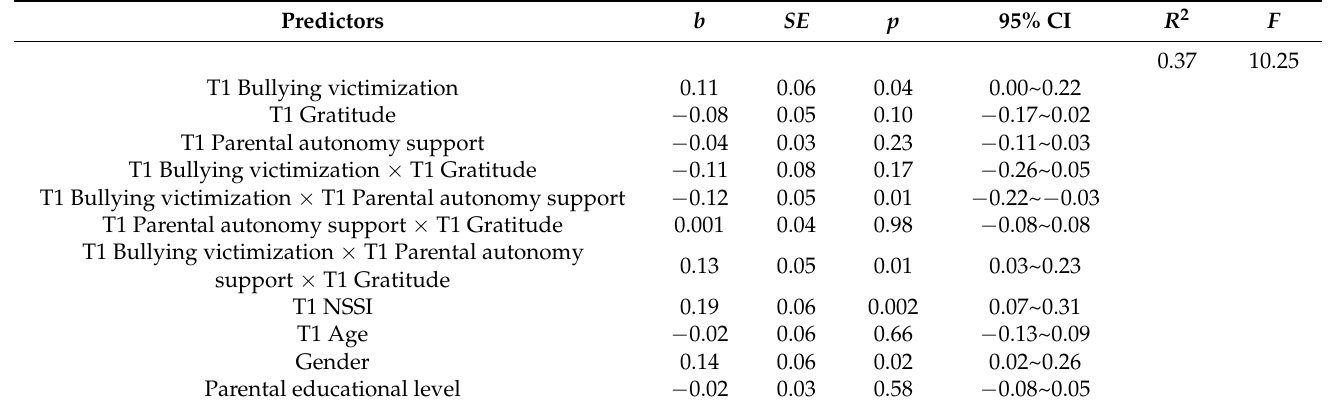
Table 3. Regression analysis examining the associations of bullying victimization, gratitude, and parental autonomy support with